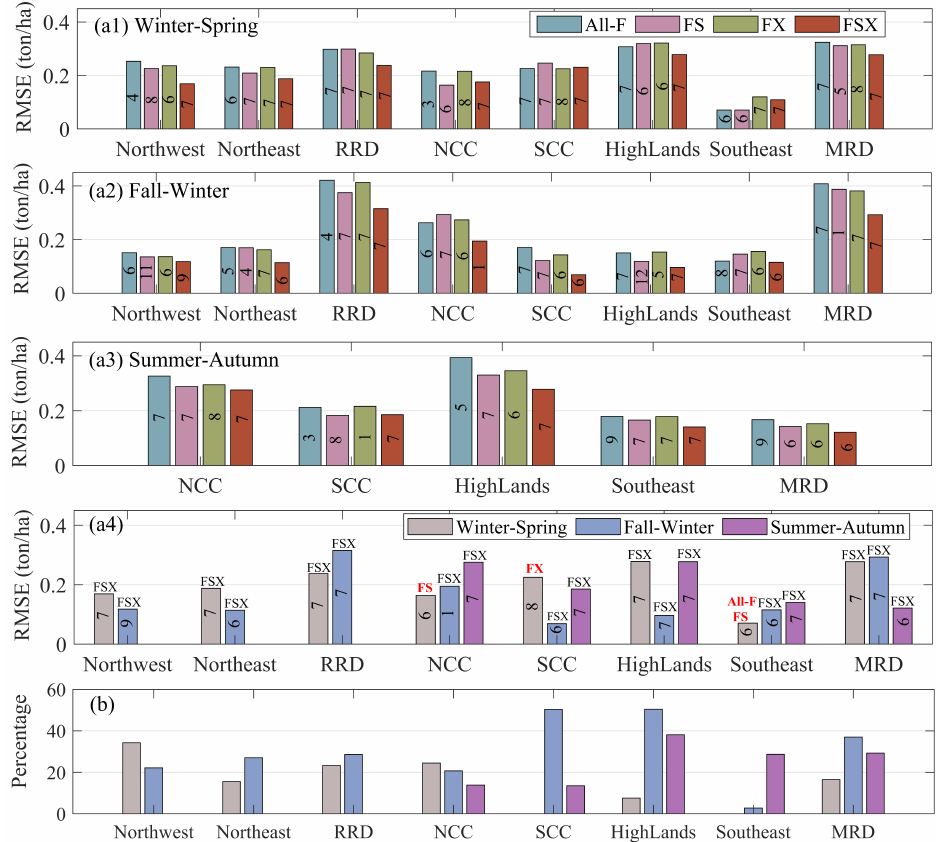
Figure 5. ( a1 – a3 ) display RMSE values of the best models generated from separate All-F, FS, FX, and FSX sets, while ( a4 ) presents the RMSE of the overall best model selected over different feature subsets (All-F, FS, FX, and FSX) for each rice season. The numbers in the columns refer to the used ML method: 1 (linear), 3 (SVMQuaratic), 4 (SVMCubic), 5 (SVMRBF), 6 (Tree), 7 (EmbBoostTree), 8 (EmbBagTree), 9 (ANNReLu), 11 (ANNSigmoid), and 12 (ANNNone). The text at the top of the column denotes the dimensionality reduction techniques used; ( b ) The accuracy improvement of the best overall models compared with the All-F-based